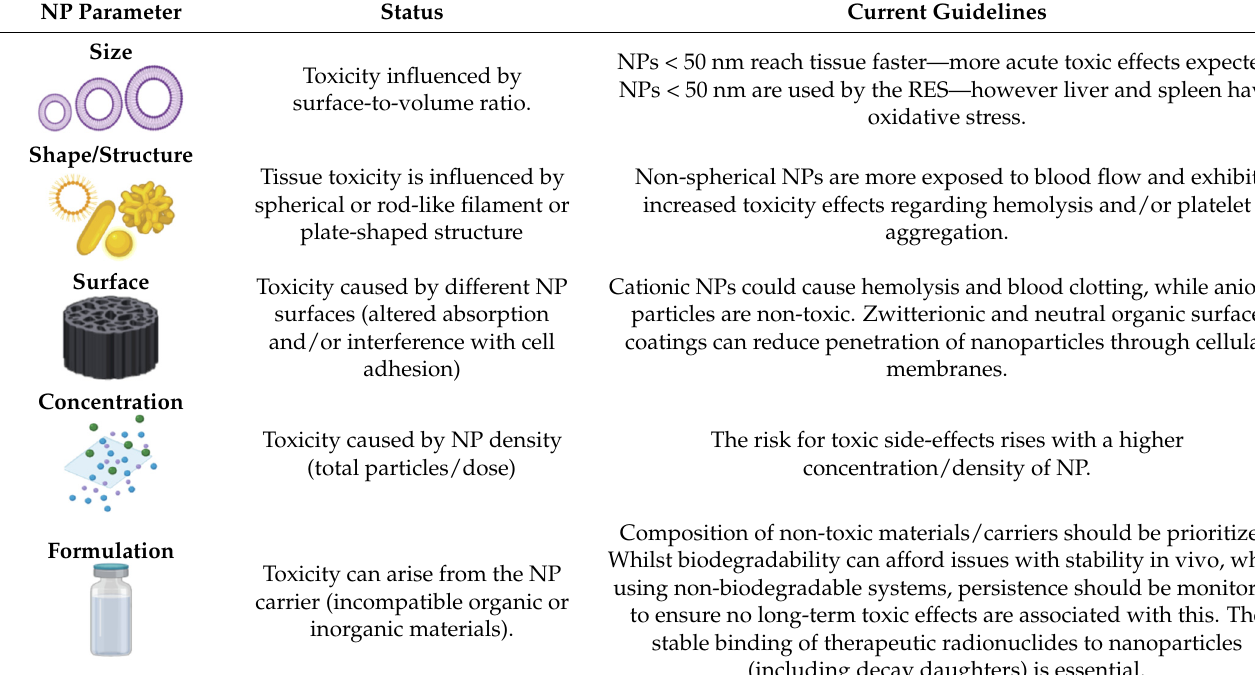
Table 2. Parameter-dependent nanoparticle-derived toxicity [53,63–66] (Figures created with BioRender.com (accessed on 18 April 2021)).